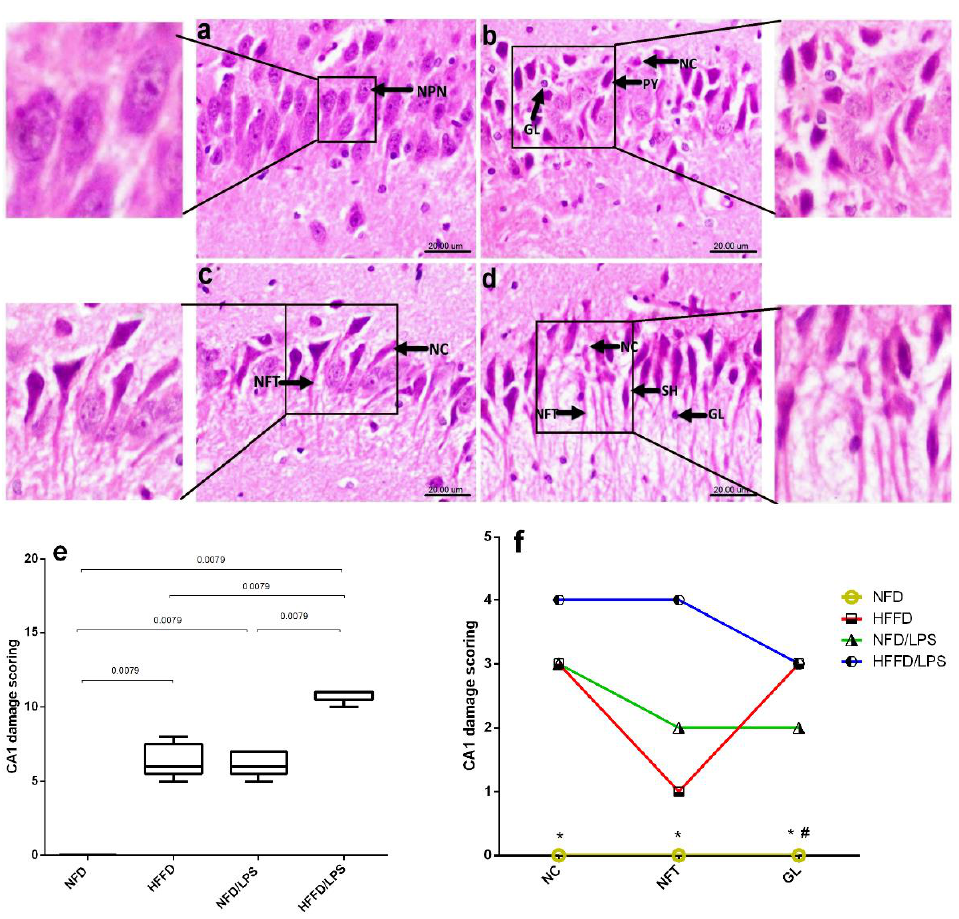
Figure 3. Effects of LPS and/or HFFD on hippocampal CA1 histopathological examination in rats after 9 weeks. The photomicrograph of H&E stained section from CA1 region of the hippocampus of ( a ) NFD shows normal histological architecture with tightly packed normal pyramidal neurons having large vesicular nuclei (NPN), while section of ( b ) HFFD, shows pyknosis (PY) and necrosis (NC) of pyramidal neurons with proliferation of glia cells (GL). Section of ( c ) NFD/LPS reveals necrosis (NC) of pyramidal neurons with neurofibrillary tangles (NFT) in some neurons and that of ( d ) HFFD/LPS, shows a marked necrosis (NC) of pyramidal neurons with flame-shaped neurofibrillary tangles (NFT) and proliferation of glia cells (GL) (Scale bar 20 µm, × 600). Panel ( e ) represents collective scores of CA1 damage presented in box and whisker and analyzed using the Mann – Whitney test between 2 groups, and panel ( f ) represents individual CA1 damage scores expressed as median (max-min) and analyzed using the Kruskal –Wallis test, followed by Dunn’s post hoc test ( p < 0.05), as compared from (*) HFFD/LPS and (#) HFFD. Rats were fed with NFD or HFFD for 8 weeks; the NFD and HFFD groups either received a single dose of LPS (2 mg/kg −1 , i.p) or not and all groups continued on NFD for another week.